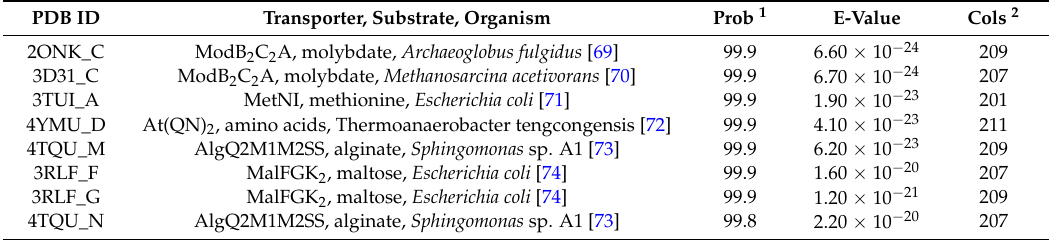
Table A2. Top results (Prob 1 > 50) from searching the PDB using the HHpred server [36] with BilEB (residues 1–231) as the query sequence.